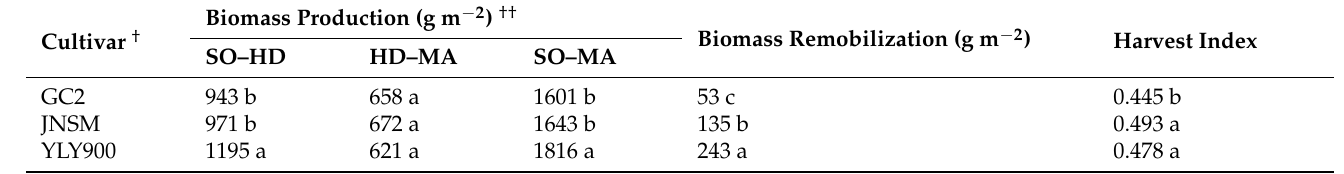
Table 4. Biomass production and translocation of three rice cultivars across two years (2019 and 2020).